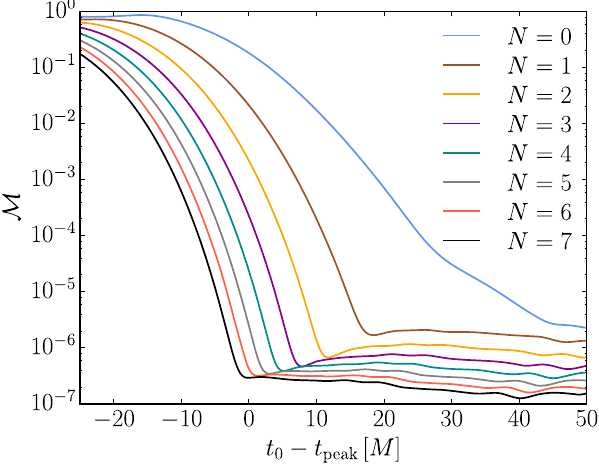
FIG. 1. Mismatches as a function of time for the eight models, each including up to N QNM overtones. The mismatch associated with each model at a given t 0 corresponds to the mismatch computed using Eq. (2), between the model and the NR wave- form for t ≥ t 0 , where t 0 specifies the lower limit used in Eq. (3). Each additional overtone decreases the minimum achievable mismatch, with the minimum consistently shifting to earlier